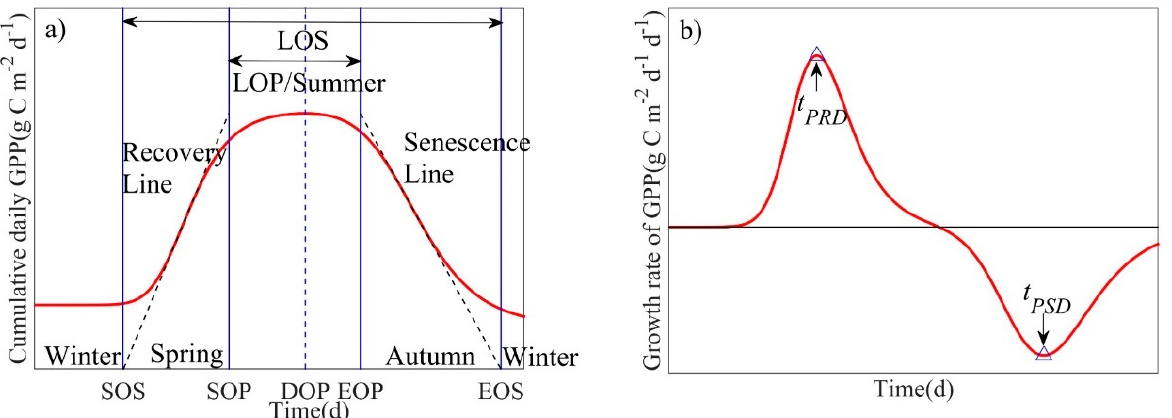
Figure 2. Schematic diagram of annual ecosystem-scale phenological process characteristics derived from measured cumulative daily gross primary production (GPP). ( a ) A ( t ) is the fitted curve shown in red, and the recovery line ( A RL ( t )) and the senescence line ( A SL ( t )) are shown as black dotted asymptotic lines on the left and right, respectively. ( b ) k ( t ) is the fitted curve shown in red, where t PRD denotes peak recovery day (d), and t PSD denotes peak senescence day (d) [26].